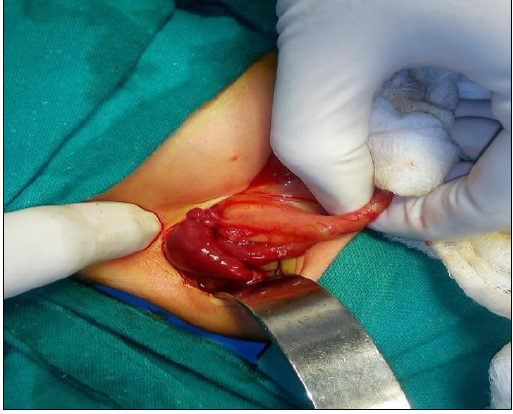
Figure 3: Case 3- Right sided stomach and polysplenia.